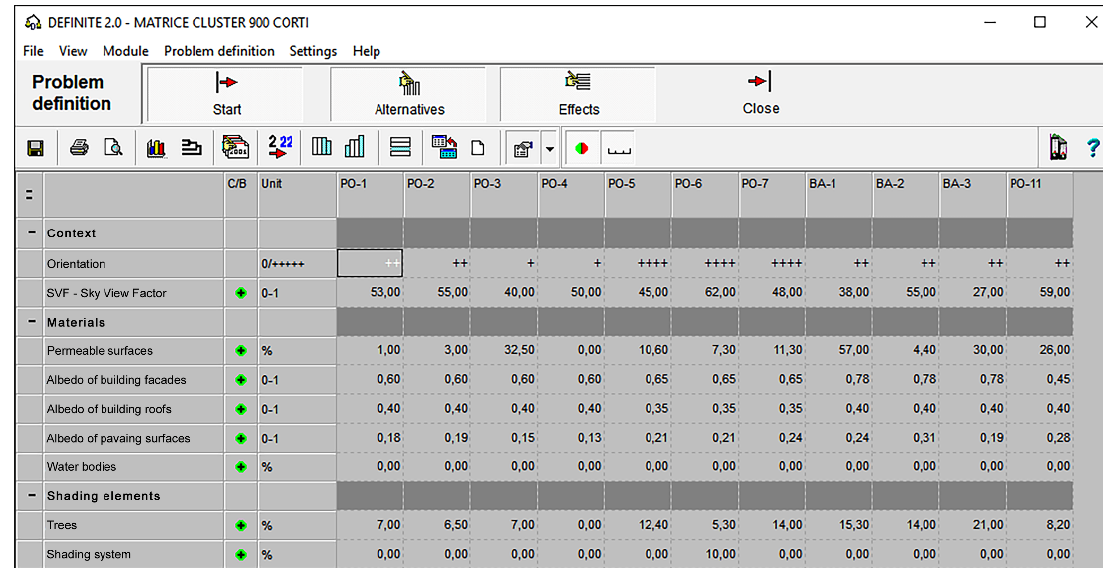
Figure 6. Definition of the indicators system.